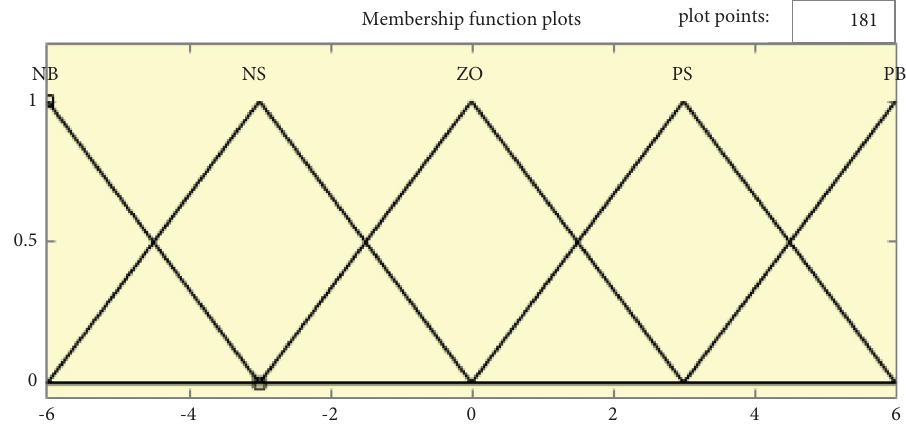
Figure 3: Membership function of E and EC.